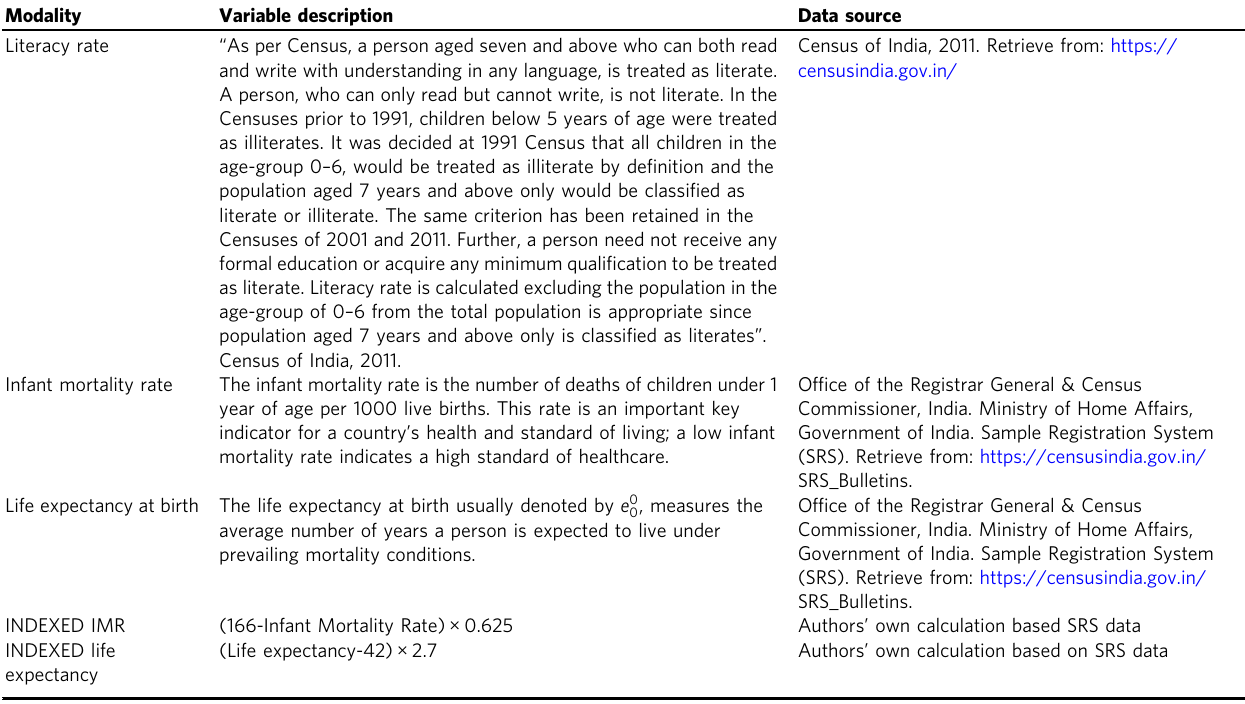
Table 9 Description of the variables utilised for construction of Physical Quality of Life Index.